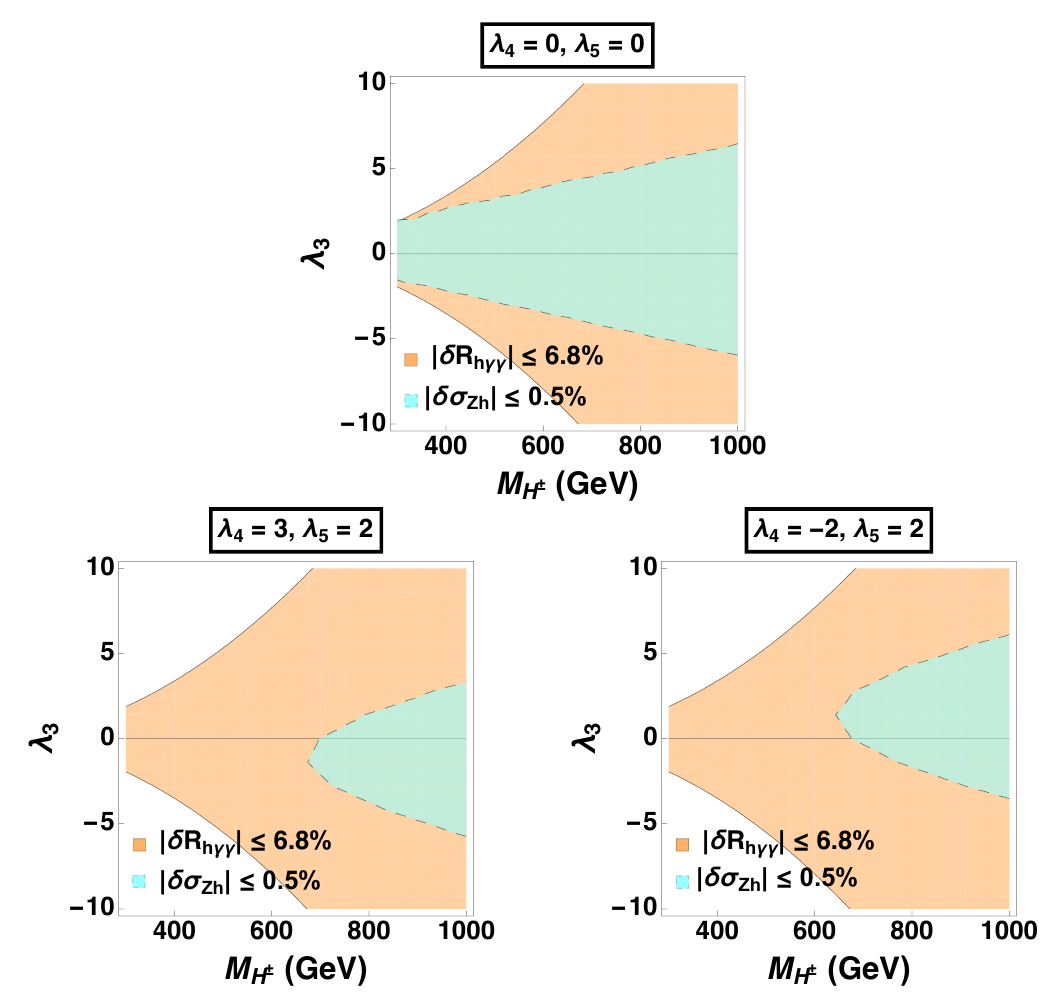
) plane for | δσ 0 . 5% (cyan area outlined with dashed lines) Figure 5. Contours in ( λ 3 , M Zh | ≤ H ± and | δR 6 . 8% (orange area outlined with solid lines) in inert double model. From left to right hγγ | ≤ panel, λ and λ are set at different values. The positive and negative λ shifts the contour by Zh 4 5 4 precision measurement downward and upward accordingly. The non-zero λ makes greater lower 5 bound of M compared to vanishing λ 5 H ±